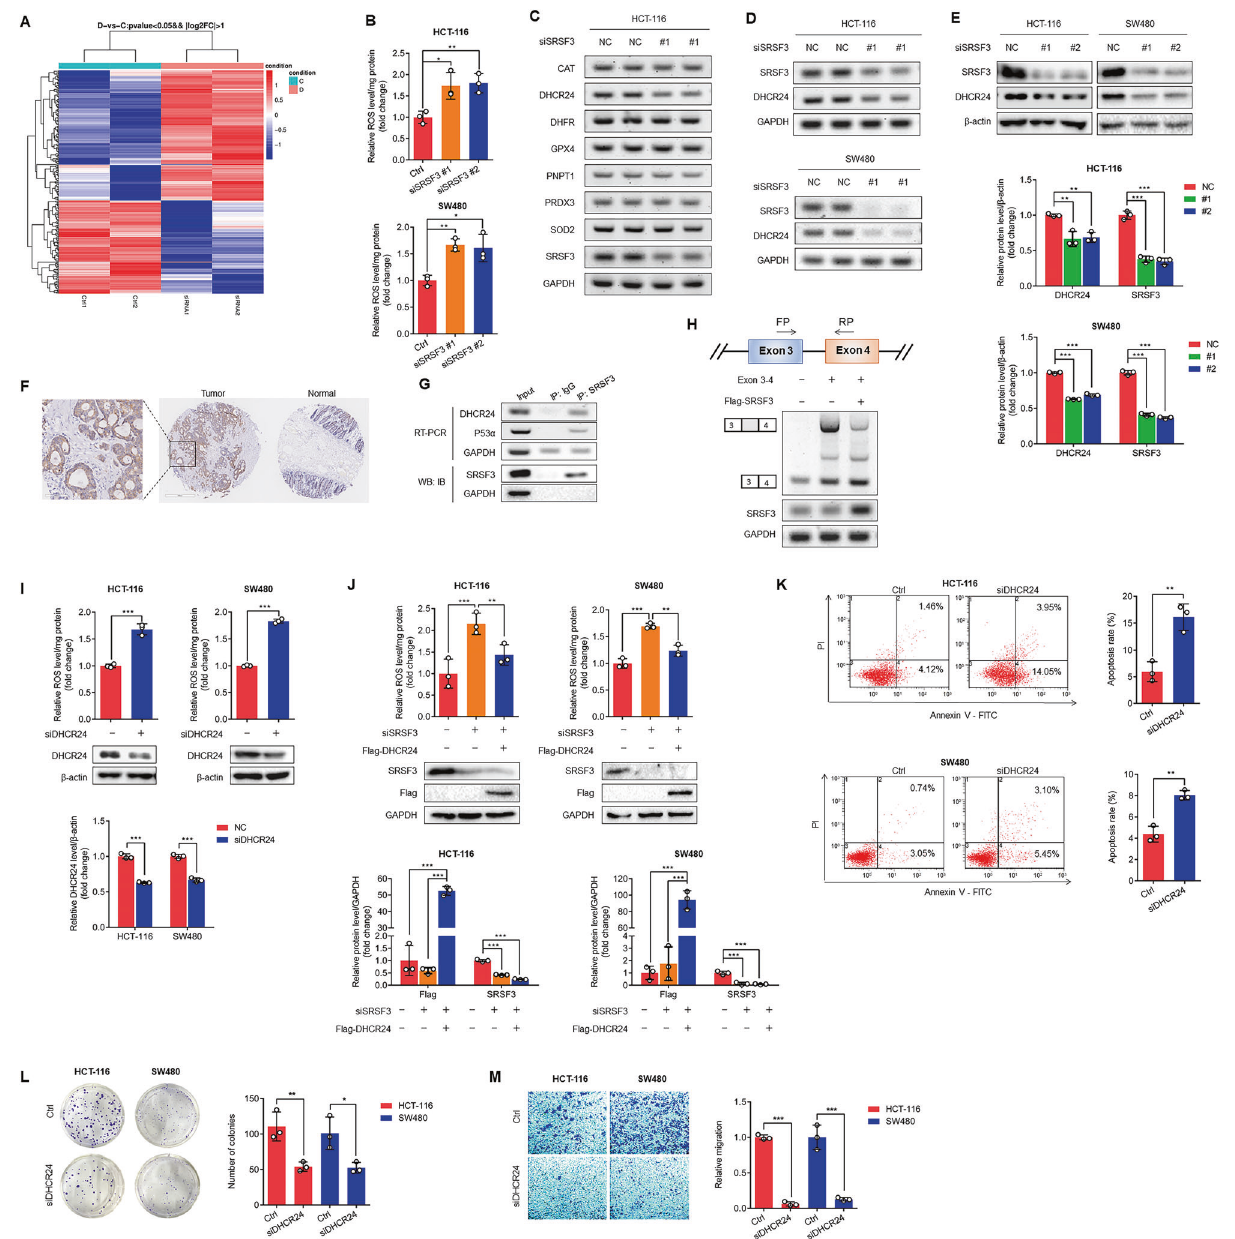
Fig. 2 DHCR24 was responsible for SRSF3-induced ROS production. A RNA-seq data showed the effects of SRSF3 silencing on gene expression in HCT-116 cells, which were transfected with siRNA control or SRSF3 siRNA for 48 h. B The effects of SRSF3 silencing on ROS production. C RT – PCR results showed the effects of SRSF3 silencing on the mRNA expression of CAT, DHCR24, DHFR, GPX4, PNPT1, PRDX3 and SOD2. D RT – PCR results showed the effects of SRSF3 silencing on the expression of DHCR24 mRNA. E WB results showed the effects of SRSF3 silencing on the expression of DHCR24 protein. HCT-116 and SW480 cells were transfected with siRNA control or SRSF3 siRNA for 48 h, as shown in Fig. B-E. F IHC staining of DHCR24 in CRC and adjacent tissues. G RIP results showed the interaction between SRSF3 protein and DHCR24 mRNA. H Minigene assays showed the effects of SRSF3 overexpression on DHCR24 splicing. The minigene contains exons 3-4 of DHCR24. HCT-116 cells were transfected with minigene expression vector and Flag-SRSF3 for 48 h. I The effects of DHCR24 silencing on ROS production in HCT-116 and SW480 cells that were transfected with vehicle control or DHCR24 siRNA for 48 h. J The effects of DHCR24 overexpression on SRSF3 silencing-induced ROS production in HCT-116 and SW480 cells that were transfected with SRSSF3 siRNA alone or co- transfected with Flag-DHCR24 for 48 h. K Annexin V-FITC/PI staining and fl ow cytometric analysis to investigate the effects of DHCR24 silencing on the apoptosis of HCT-116 and SW480 cells that were transfected with vehicle control or DHCR24 siRNA for 72 h. L Colony formation assays for investigating the effects of DHCR24 knockdown on the proliferation of HCT-116 and SW480 cells that were transfected with DHCR24 siRNA for 24 h and then incubated in six-well plates for 2 weeks. M Transwell migration assays for investigating the effects of DHCR24 knockdown on the migration of HCT-116 and SW480 cells that were transfected with DHCR24 siRNA for 48 h. Each experiment was performed in triplicate. Data represent mean ± SD. Signi fi cance was assessed by two-sided t test. *** P < 0.001; ** P < 0.01; * P < 0.05.